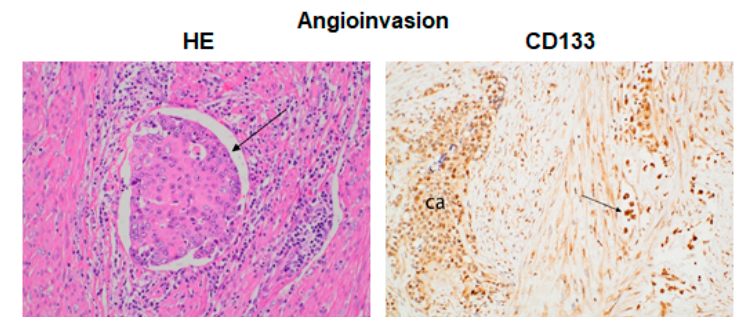
Figure 1. The level of CD133 expression in endometrial carcinoma as evaluated by immunohisto- chemical staining. ( A ) The level of CD133 expression in tumors displaying different grading. G1, well-differentiated (G1) endometrial adenocarcinoma exhibiting exclusively glandular pattern (g). HE, hematoxylin-eosin staining; CD 133 stain, cytoplasmic pattern (arrowhead); magnification 200 × . G2, moderately differentiated (G2) endometrial adenocarcinoma with glandular (g) and solid (s) areas; CD133 staining, cytoplasmic pattern (arrowhead) and nuclear pattern (arrow); magnification 200 × . G3, poorly differentiated (G3) endometrial adenocarcinoma exhibiting almost an exclusively solid pattern (s); HE, magnification 200 × ; CD133 stain, cytoplasmic and nuclear (arrow) pattern in almost all cells; magnification 100 × . ( B ) Poorly differentiated (G3) endometrial adenocarcinoma, angioinvasion-cancer cells inside the lymphatic vessel (arrow); HE stain, magnification 400 × ; poorly differentiated (G3) endometrial adenocarcinoma (ca), angioinvasive component inside the lymphatic vessel exhibiting nuclear staining (arrow); CD133 staining; magnification 200 × .